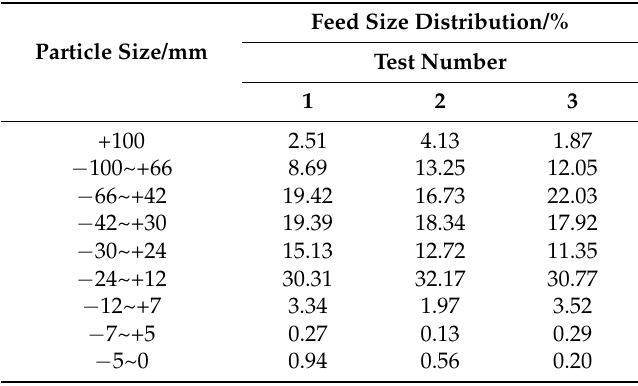
Table 2. Feed particle size distribution.